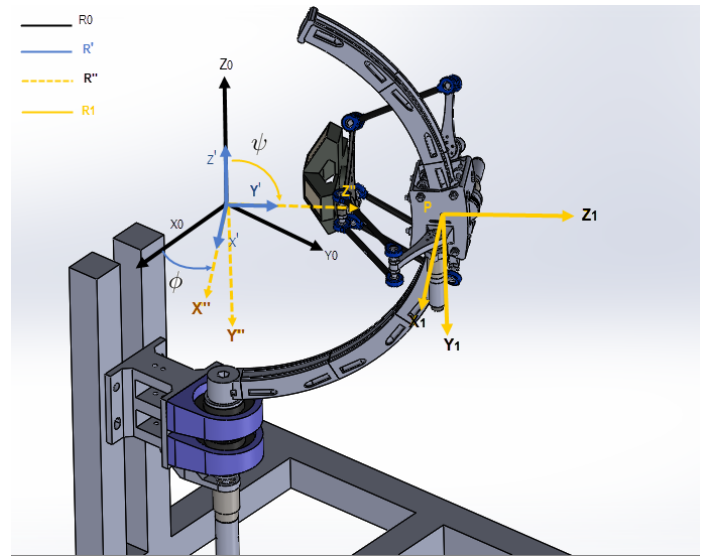
Figure 10. Transformations between frames.